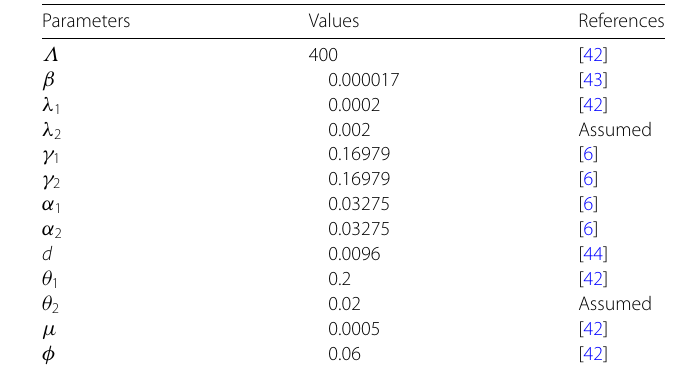
Table 2 Parameter